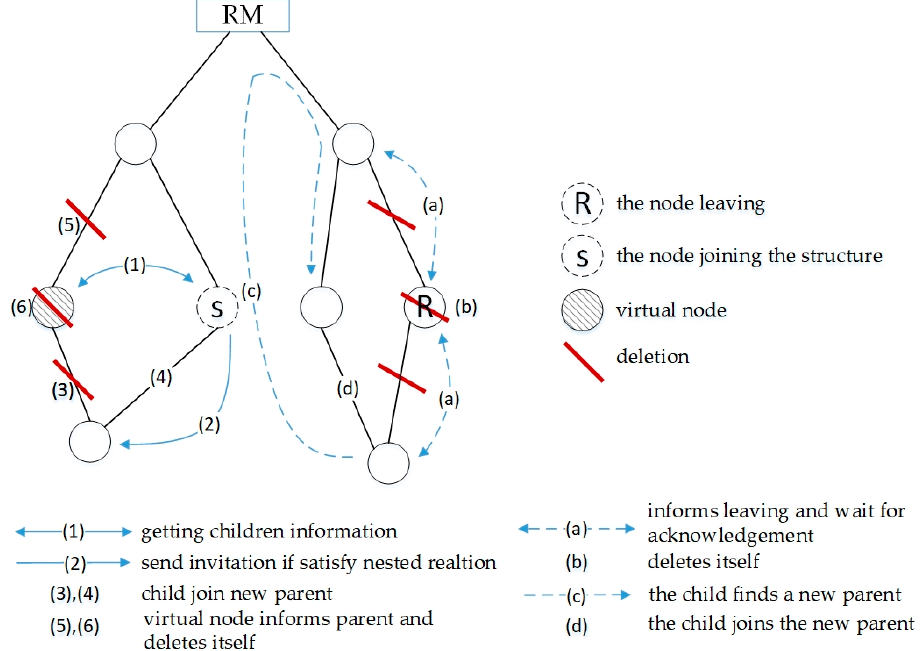
Figure 6. Virtual node replacement and node leaving.